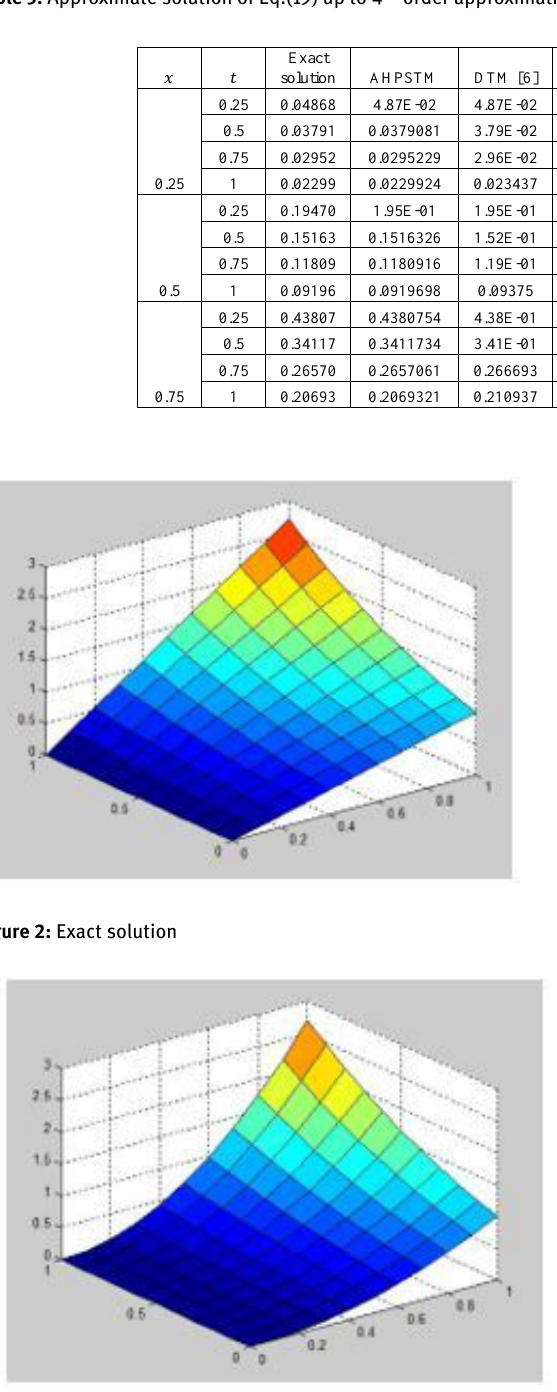
Figure 5: Approximate solution of Eq. (27) using AHPSTM Null hypothesis: H A : µ A = µ A , H B : µ B = µ B , H C : 0 0 0 1 2 j 1 2 j , µ C 1 = µ C 2 j where µ k , ; k = A ; B ; C denotes the exact solution of 1 (11), (19) and (28) respectively, while µ k ; k = A ; B ; C ; j 2 j